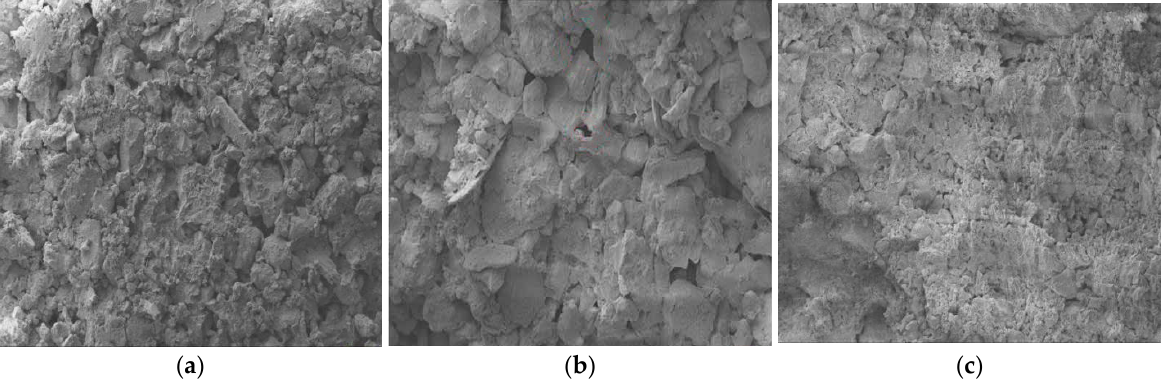
Figure 2. SEM images. ( a ) SEM image of upper soil; ( b ) SEM image of middle soil; ( c ) SEM image of subsoil.